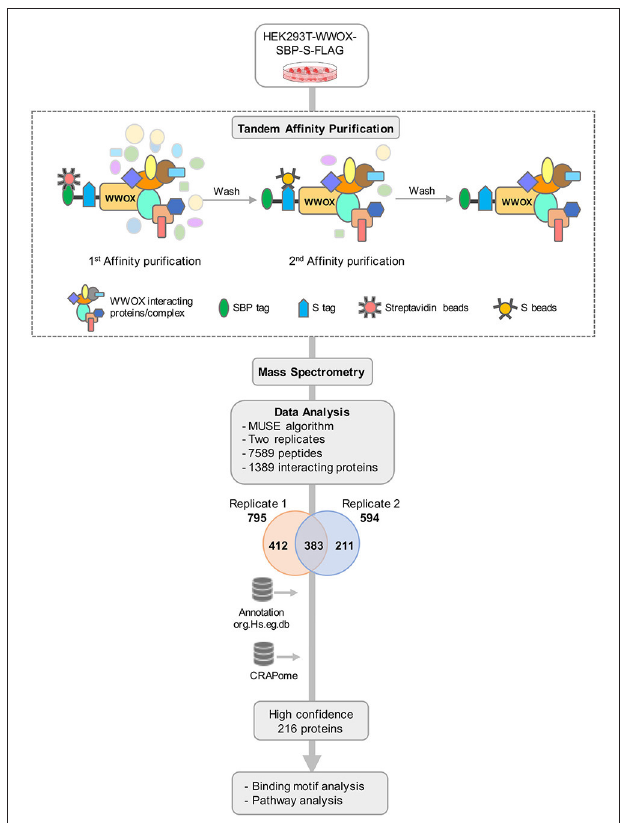
FIGURE 1 | TAP-MS based Proteomic Profiling of WWOX Interactome. Schematic diagram showing the major steps involved in the TAP-MS procedure and data analysis. HEK293T cells stably expressing WWOX with C-terminal SFB-tag (Streptavidin binding protein (SBP)-tag, S-tag, and Flag-tag) were generated by stable transfection and puromycin selection. Following the described tandem affinity purification steps, purified protein complexes were identified by mass spectrometry analysis (LC-MS/MS), and final interacting proteins were identified after proper annotation and MUSE algorithm-based analysis to define interaction scores. Data annotation was done using Bioconductor. To remove the non-specific bindings